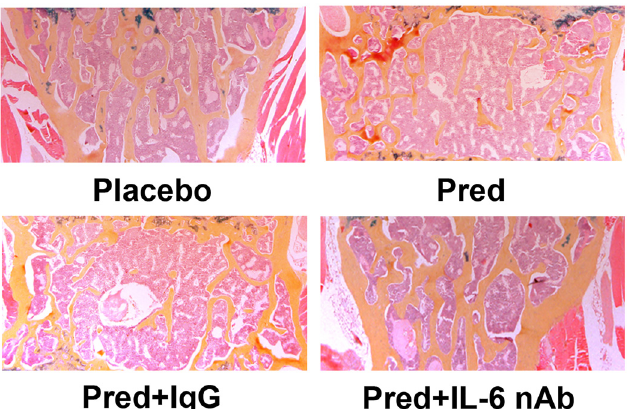
Fig 8. Cancellous bone staining of the vertebral body from an osteoporotic mouse treated with an IL-6 neutralizing antibody. An IL-6 neutralizing antibody was used to treat mice implanted with placebo or prednisolone pellets. IgG was used as a control. The vertebral bodies were cut into sections, and hematoxylin and orange G staining was